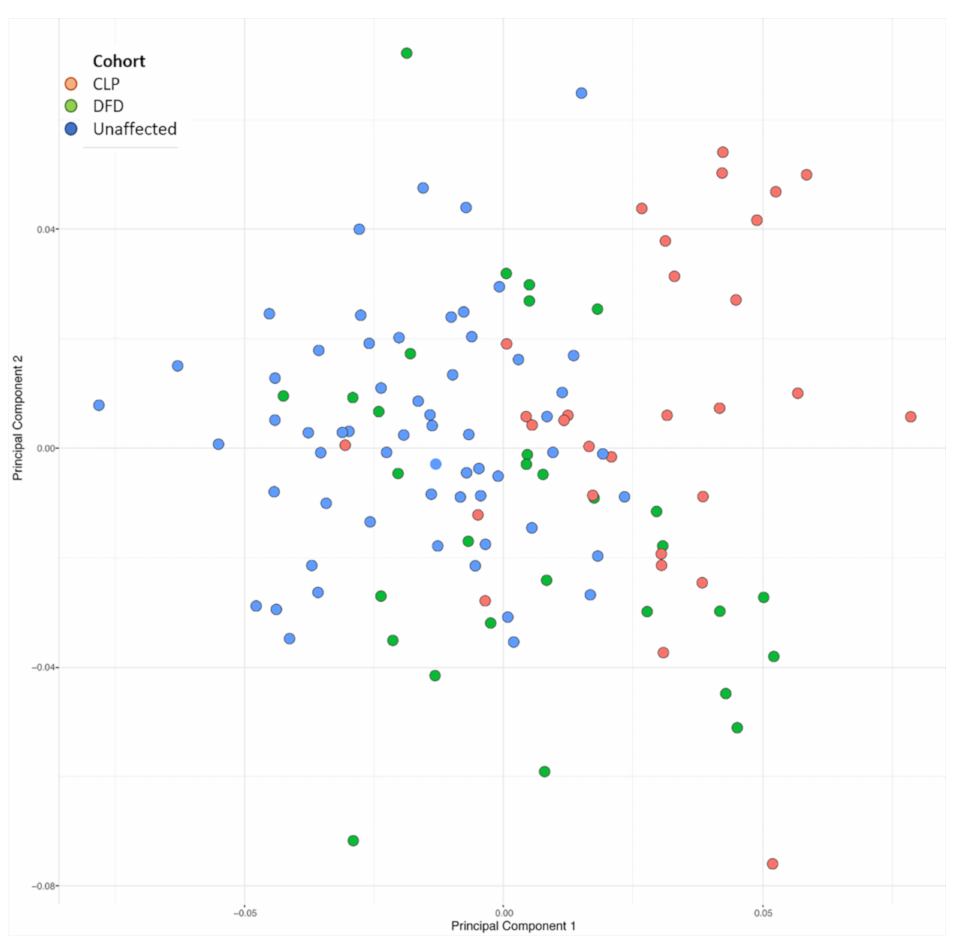
Figure 2. Plot of the first two PC axes from the principal component analysis, which explains 29.6% of the shape variance in the combined sample of patients including the una ff ected controls (Class I), DFD, and nsCLP. Using PCA, we are able to demonstrate the overall craniofacial shape di ff erences between the three groups, with the DFD group having overlap with the una ff ected controls and the nsCLP group. The fact that there is little overlap between the una ff ected controls and the nsCLP indicates that, while the groups were age- and gender-matched, the overall clusters are distinct in craniofacial shape and skeletal variances. The cohorts are indicated by color of the